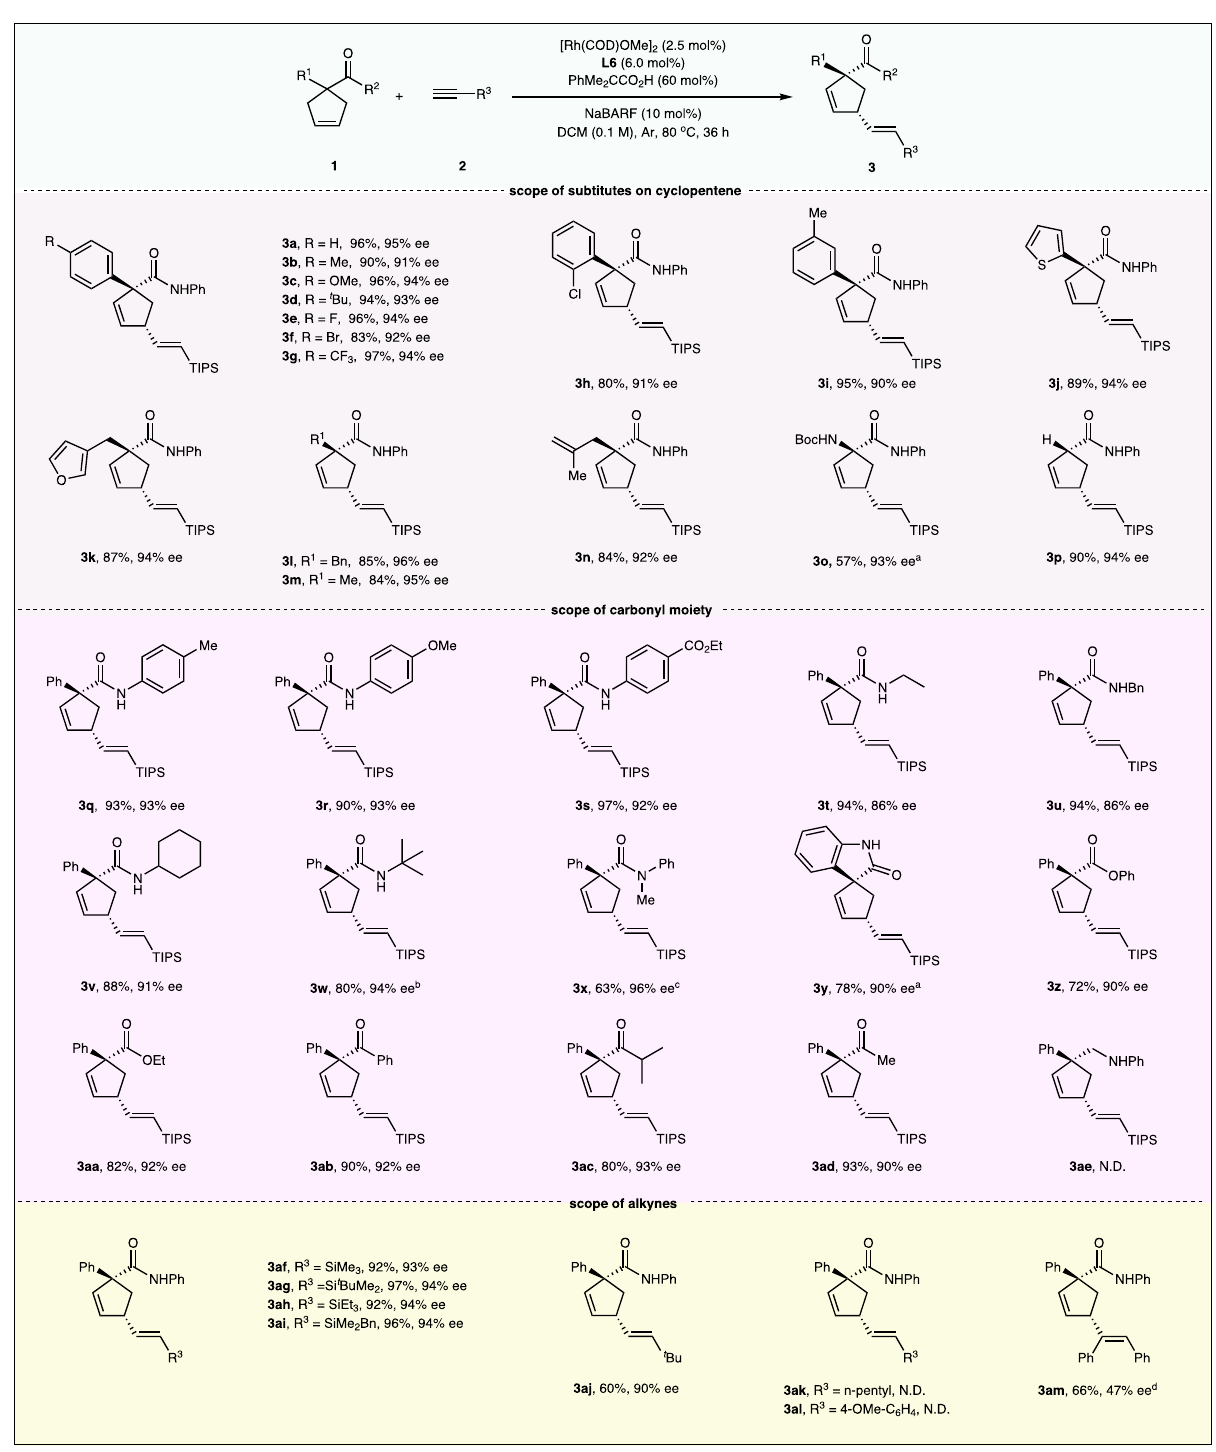
Fig. 2 Substrate scope. Reaction conditions: 1a (0.10 mmol), 2a (0.30 mmol), [Rh(COD)OMe] 2 (2.5 mol%), L6 (6.0 mol%), PhMe 2 CCO 2 H (60 mol%), NaBARF (10 mol%), DCM (1.0 mL), 80 o C, 36 h, under argon. Isolated yields, d.r. > 20:1, E/Z > 20:1, determined by 1 H NMR analysis. The ee values were determined by chiral HPLC analysis. a [Rh(COD)OMe] 2 (5.0 mol%) , 72 h. b 72 h. c [Rh(COD)OMe] 2 (5.0 mol%). d [Rh(COD)Cl] 2 (5.0 mol%), L5 (12 mol%), Ph 3 CCO 2 H (60 mol%), NaBARF (20 mol%), d.r. > 20:1, Z/E >